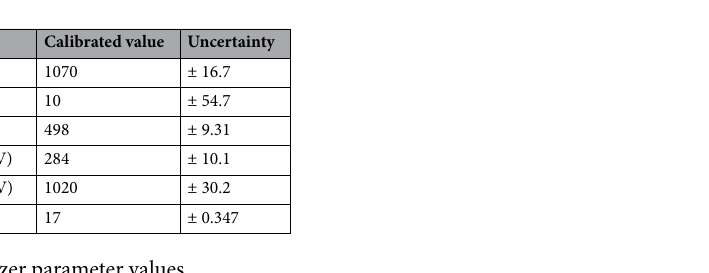
Table 3. Calibrated digitizer parameter